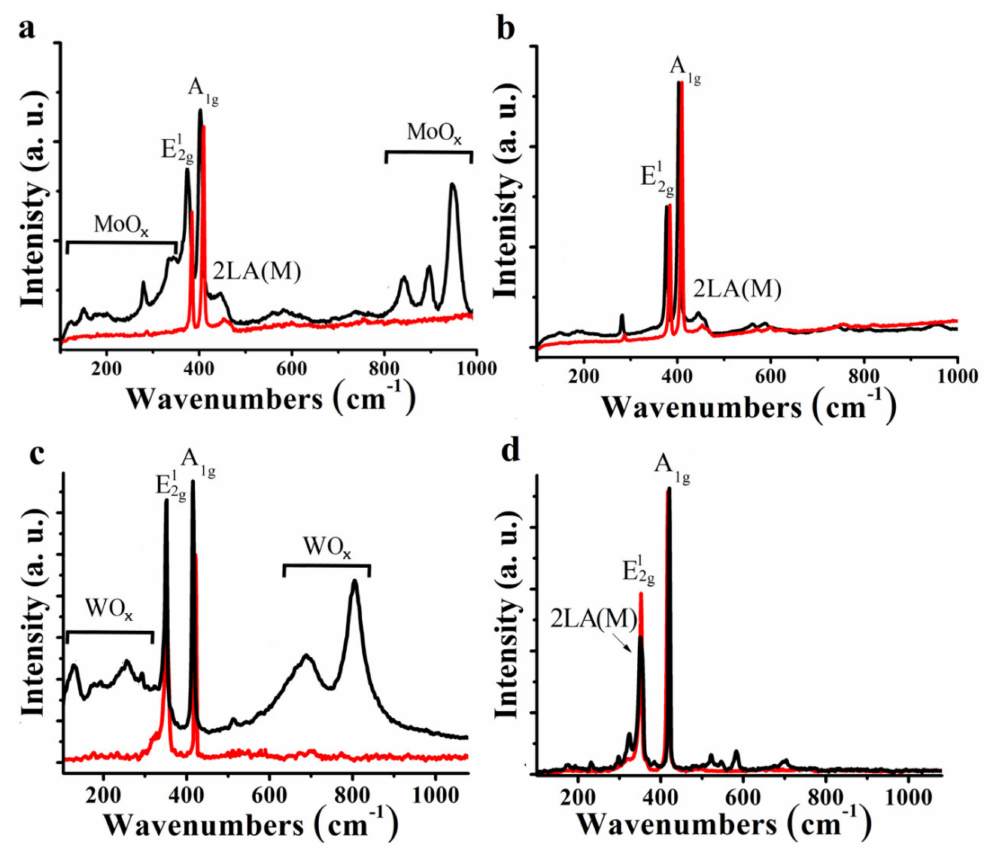
Figure 4. Raman spectra acquired at ambient conditions upon excitation at 514 nm with 0.1 mW / 4 µ m 2 (red line) and 0.9 mW / 4 µ m 2 (black line) laser radiance for ( a ) exfoliated MoS 2 , ( b ) MoS 2 / pyrene 1a, ( c ) exfoliated WS 2 , and ( d ) WS 2 / pyrene 1b. The E 1 2g , A 1g , and 2LA(M) peaks in the black spectra are downshifted due to laser